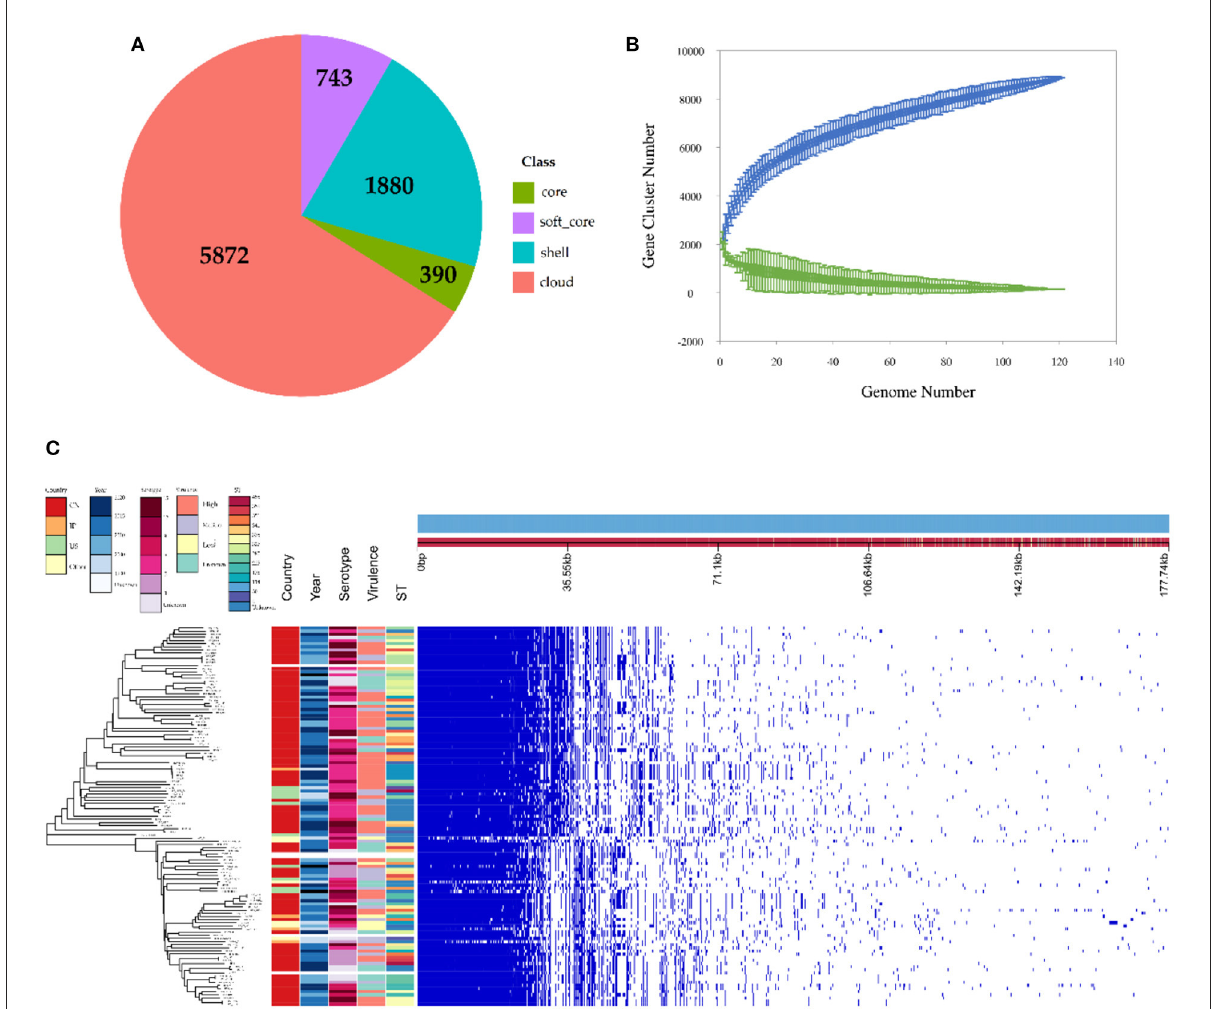
FIGURE3 Pan-genomic and phylogenetic analysis of HPS based on 121 strains. (A) Core and accessory genes of HPS. Core: 119 ≤ strains ≤ 121; soft-core: 114 ≤ strains < 119; shell: 18 ≤ strains < 114; cloud: strains < 18. (B) Core and pan-genome curves for HPS. The blue dots and lines indicate the size of the pan-genome for each strain combination, and the relationship between pan-genome size and genome number, respectively. The green dots and lines indicate corresponding information for the core genome. (C) The left tree is a neighbor-joining phylogenetic tree constructed based on the core genes and annotated with the location of isolation, time of isolation, serotype, ST type, and virulence of each strain. The right matrix plot denotes the presence and absence of every gene over all strains by blue and white,